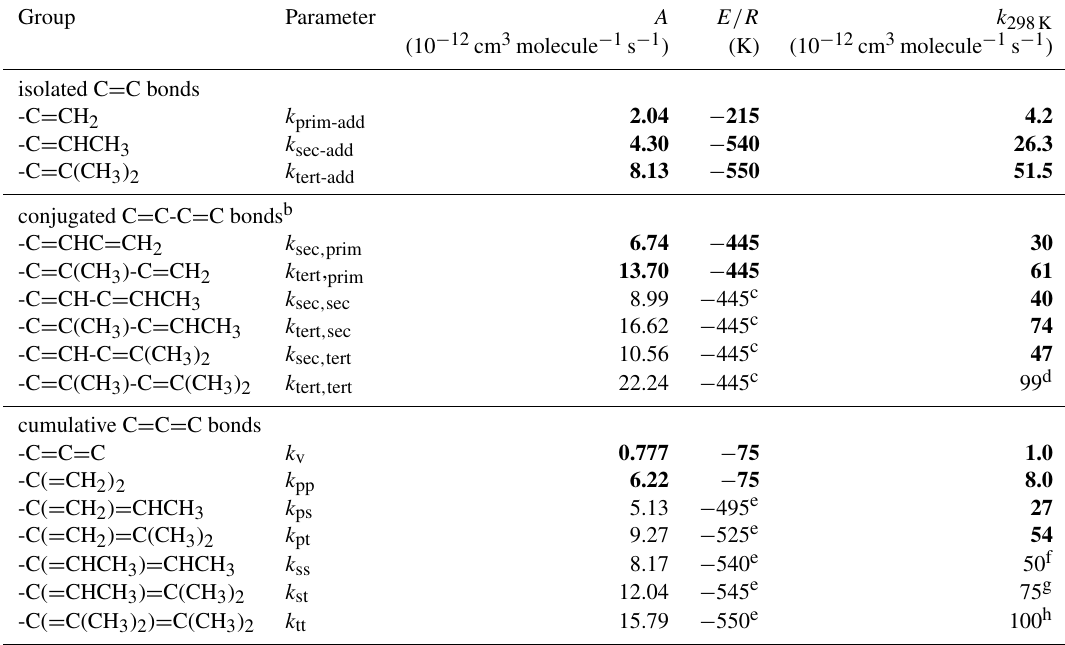
Table 10. Arrhenius parameters ( k = A exp ( − (E/R)/T ) ) for the group rate coefficients for OH addition to C = C bonds in monoalkenes and polyalkenes; and the group rate coefficient values at 298K a . Group